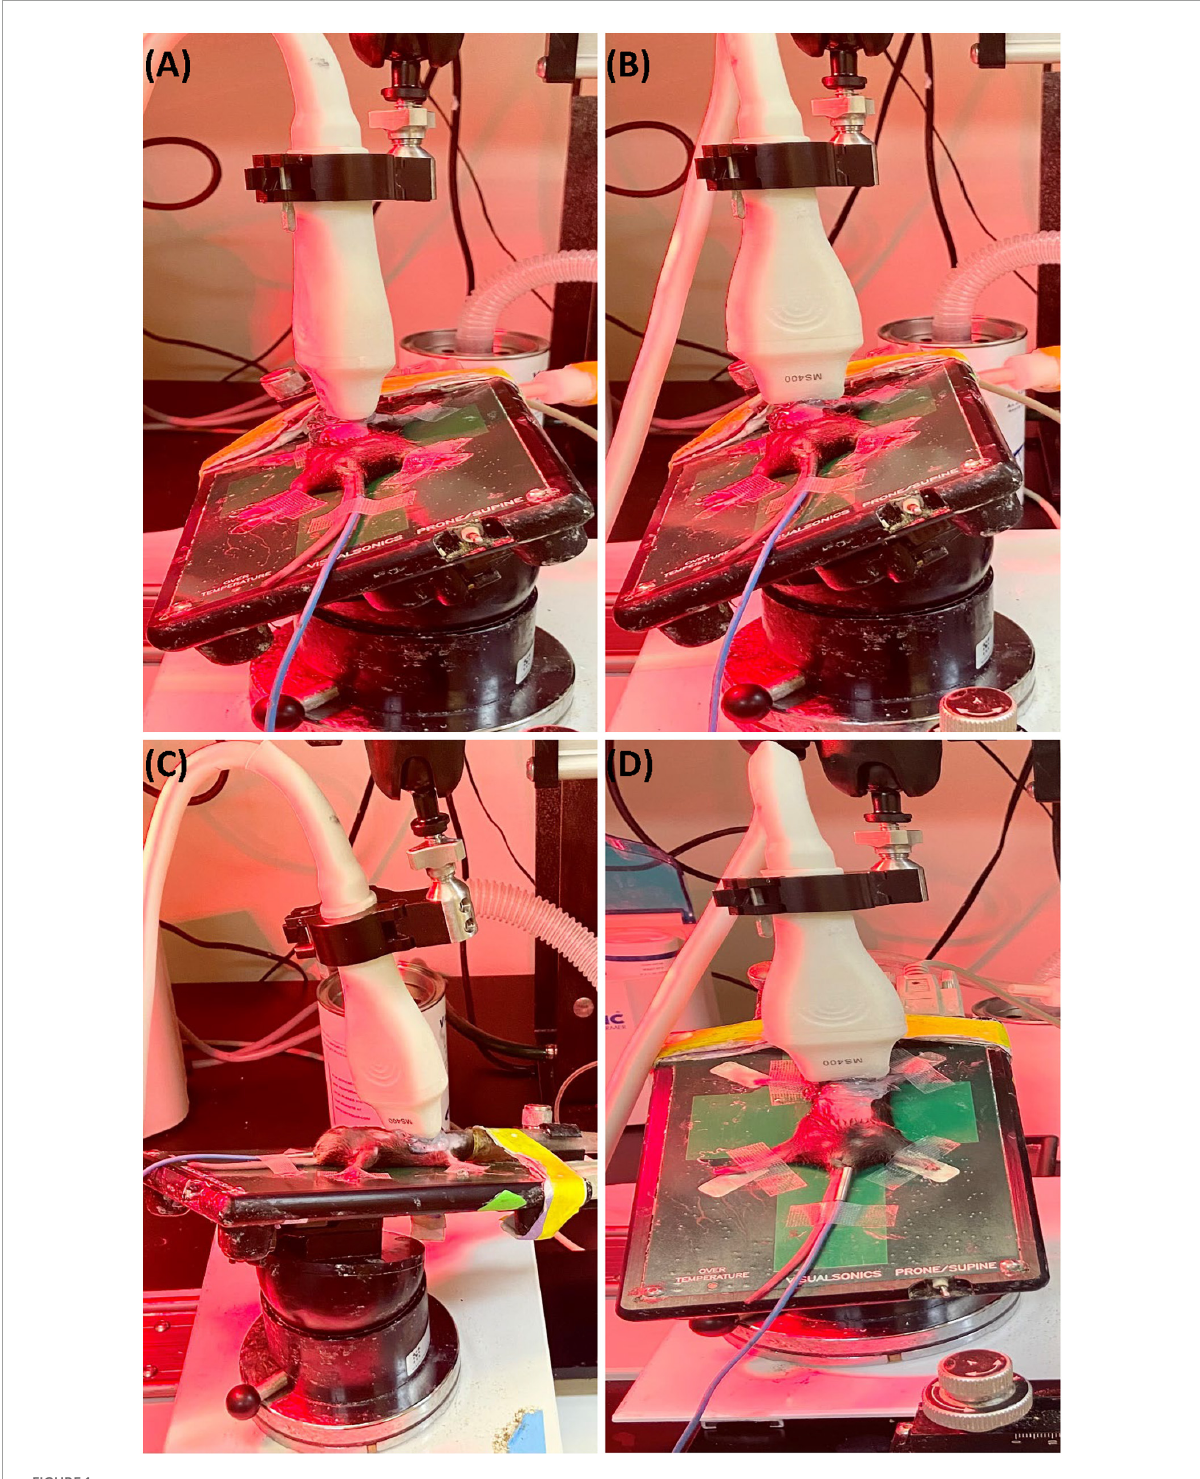
FIGURE1 (A) Representative image showing probe positioning to obtain parasternal long axis (PLAX) views. (B) Parasternal short axis (PSAX) views are derived from the PLAX view by rotating the transducer probe in the rail system to approximately 90 ◦ clockwise. (C) To obtain apical views, the transducer probe is placed diagonally toward the head. (D) Views of the aorta can be acquired by shifting the transducer probe from the PSAX view cranially to the level of the aortic